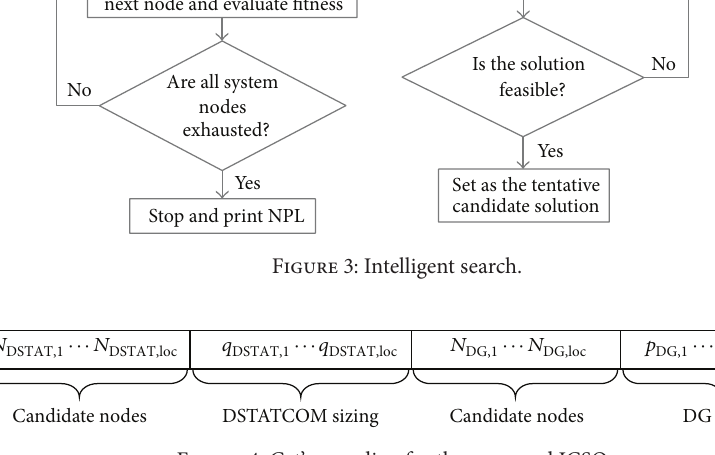
Figure 4: Cat’s encoding for the proposed